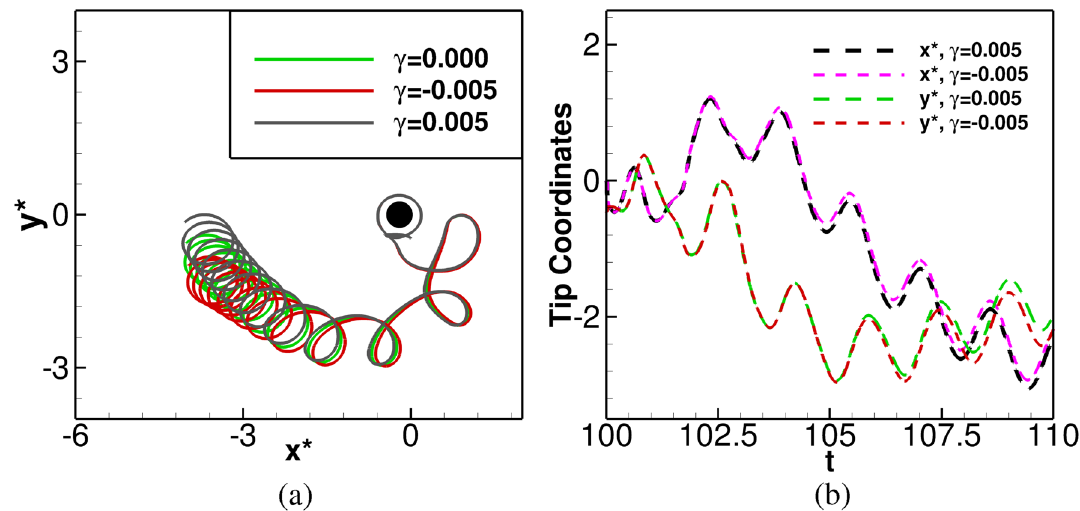
Figure 8. ( a ) Tip paths for γ = 0.000, − 0.005, 0.005 , with obstacle for 100 ≤ t ≤ 120 , ( b ) time history of ( x ∗ , y ∗ ) in 100 ≤ t ≤ 110 for γ = − 0.005, 0.005 , with the